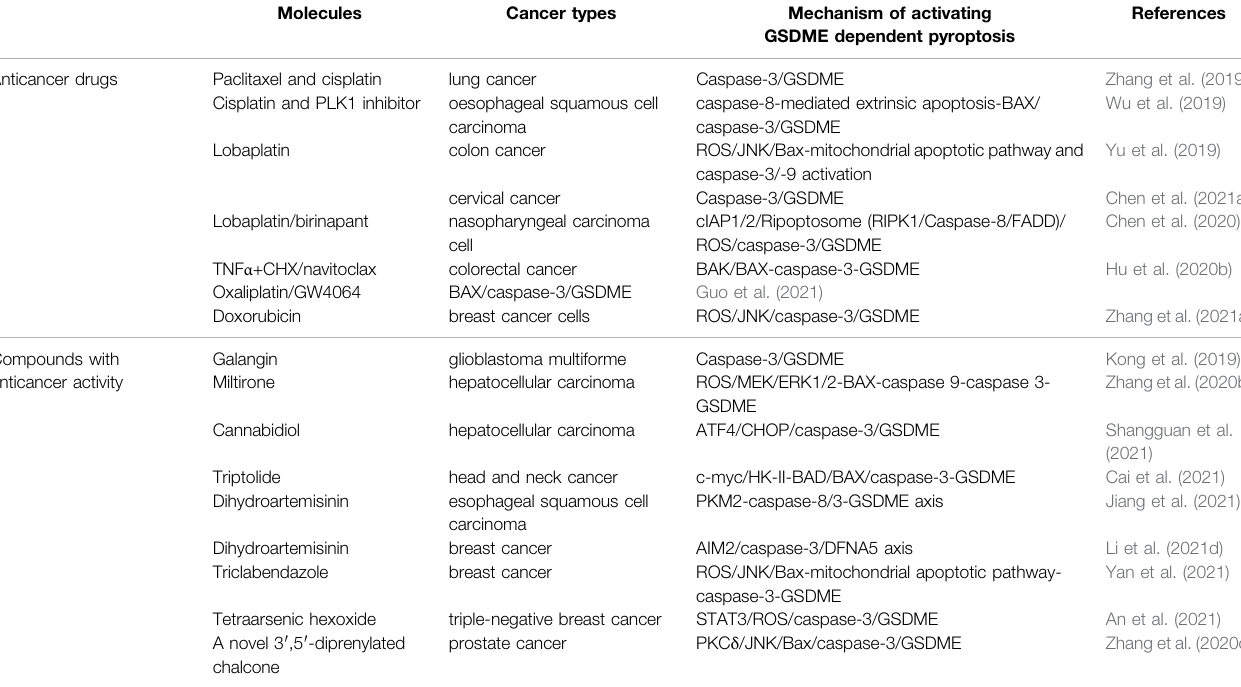
TABLE 1 | Summary of mechanisms of activating GSDME-dependent